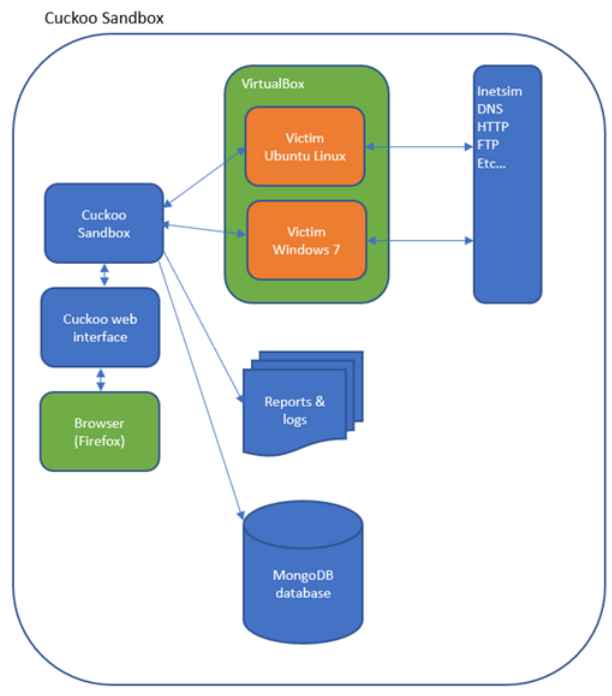
Figure 2. Cuckoo Sandbox analysis environment.